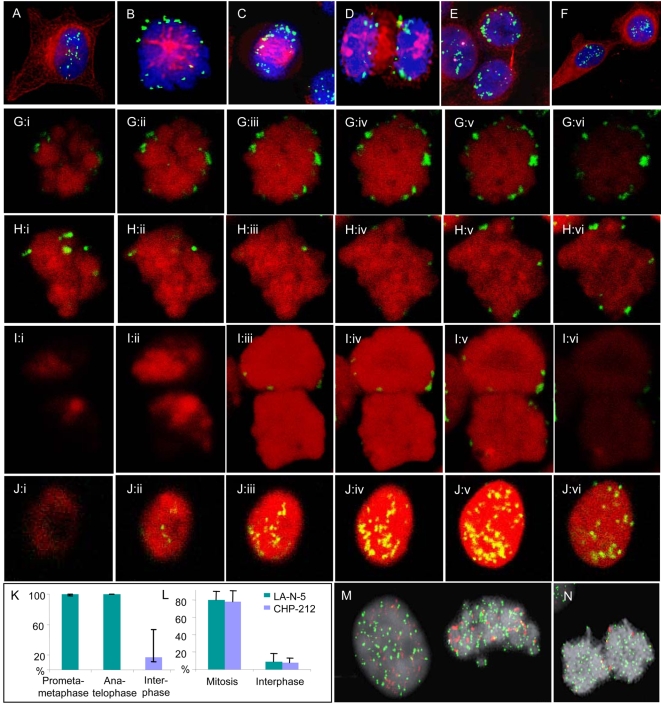
Fluorescence microscopy.All figures are from CHP-212. A–F. Combined immunofluorescence (IF) for beta tubulin (red), fluorescence in situ hybridisation (FISH) with a MYCN probe (green), and chromatin counterstaining by DAPI (blue) shows translocation of DMs to the periphery of the chromosome rosette at transition from interphase (A) to prometaphase (B); the peripheral localisation is maintained through metaphase (C), anaphase (D) and telophase (E), after which DMs again transfer to interior positions in the nucleus (F). G–J. Serial confocal optical sections (i–vi) corroborate the peripheral positions of DMs (green) at prometaphase (G), metaphase (H), and telophase (I), in contrast to a more central localisation at interphase (J); chromatin is counterstained by DRAQ5 (red). K. Proportion of peripheral DMs at prometa/metaphase, ana/telophase, and interphase; error bars denote standard deviation. L. The proportion of DM (MYCN) signals overlapping with telomeric TTAGGG-repeat signals at mitosis and interphase, respectively, in LA-N-5 and CHP-212. M–N. FISH for telomeric TTAGGG sequences (green) and MYCN (red) shows more frequent overlapping of signals for telomeres and DMs at metaphase (M, right) and telophase (N), compared to interphase (M, left).